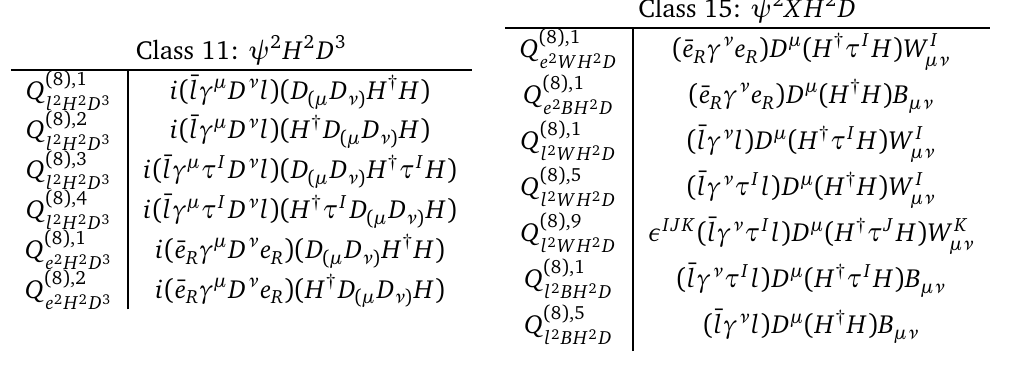
doublet, while e is the right handed leptonic L R ←→ D µ H ) B µν do not contribute as the relative